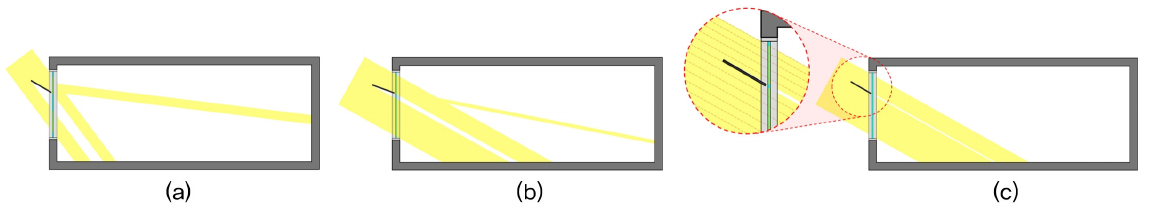
Figure 9. The inflow of natural light according to the light shelf angle in Case 1: ( a ) Middle season, Angle 30°, ( b ) Winter, Angle 20°, ( c ) Winter, Angle 30°.